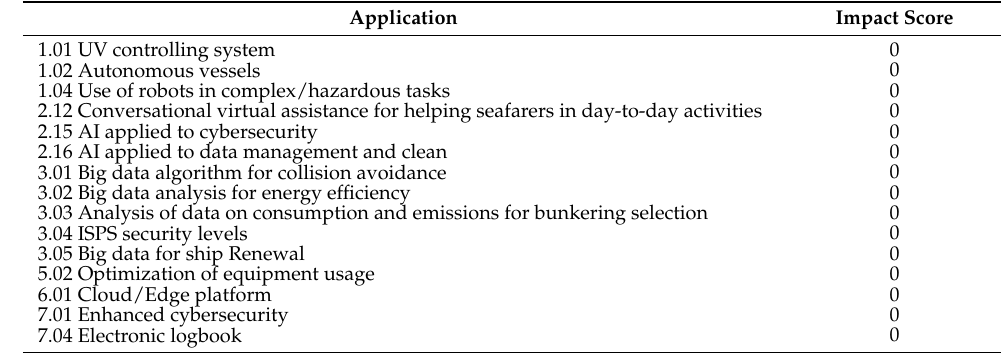
Table 13. Bottom applications on Flexibility performance